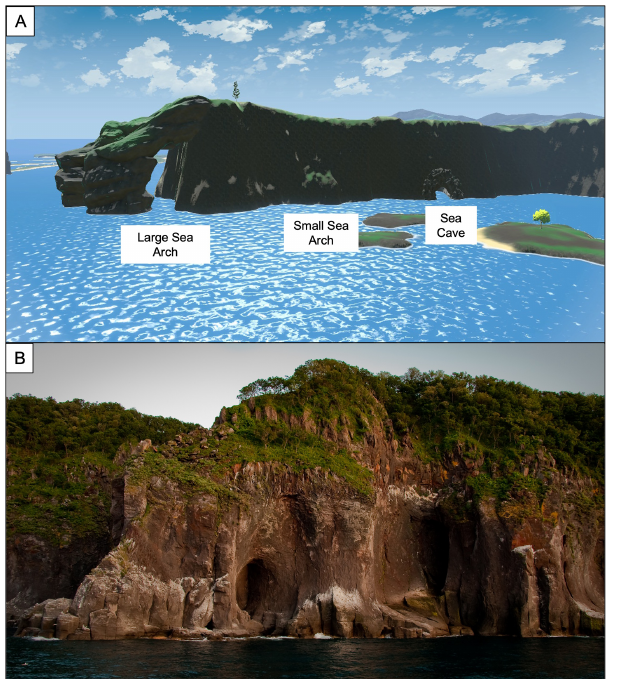
Figure 4. (a) Sea arches and sea caves that can be found along Veilstone Cape in Cobalt Coastlands, Pokémon Legends: Arceus (Fig. 1a2), ©The Pokémon Company International (2022a). (b) Photograph of coastal arches found along the Shiretoko Coast (Fig. 1b2) (civ33, 2009).